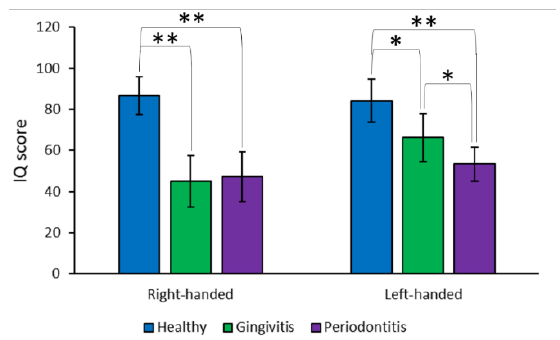
Figure 1: Comparison of IQ score shows significantly higher difference in IQ score of healthy group as compared to gingivitis and periodontitis groups in right- and left- handed individuals. *=P≤0.05,